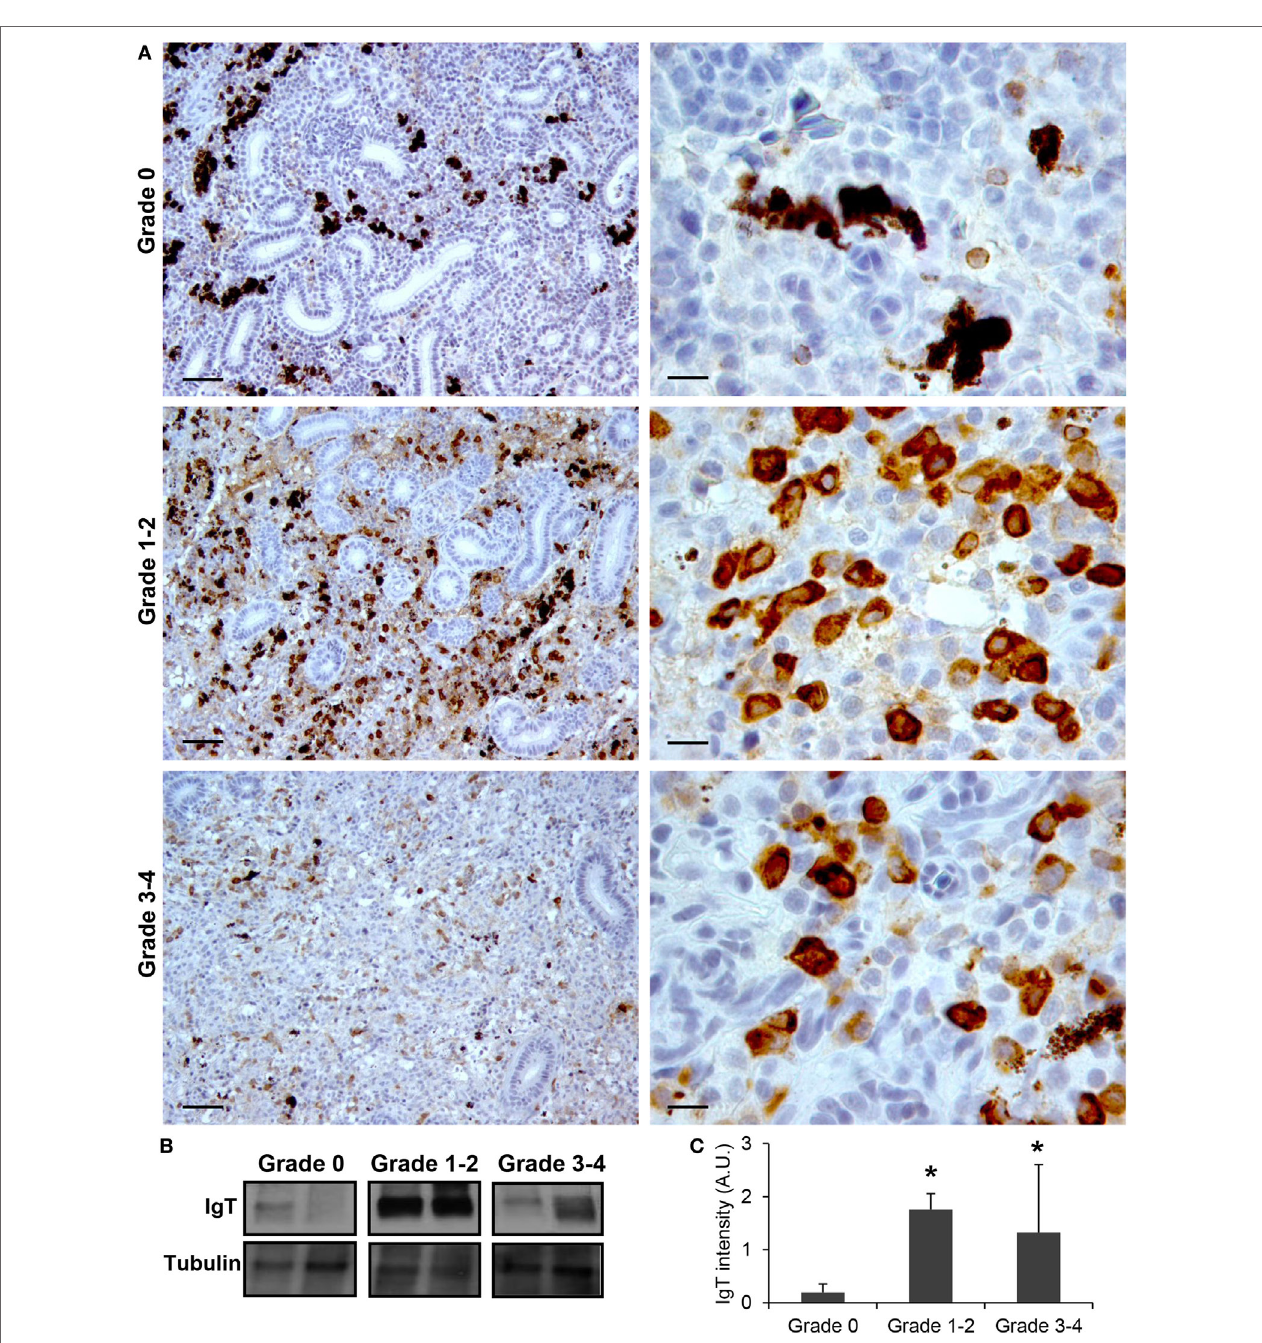
FigUre 4 | IgT production increases during proliferative kidney disease infection. (a) Immunohistochemical detection of IgT + cells in the kidney of parasite­infected (swelling grades 1–4) and parasite­naïve (swelling grade 0) fish. Representative images for fish with swelling grades 0, 1–2, and 3–4 are shown at 20 × magnification (left images, scale bars = 40 µm) and at 100 × magnification (right images, scale bars = 10 µm). IgT production in kidney samples from each fish group was analyzed by Western blot. (B) Results from two representative individuals in each group are shown. (c) Abundance of IgT was quantified by optical densitometry and normalized against α ­tubulin. Mean values in arbitrary units (A.U.) + SEM are shown ( n = 4). Asterisks (*) denote significant differences ( P < 0.05) between values obtained in grade 1–2 or grade 3–4 and grade 0 kidneys (analyzed by a two­tailed Student’s t